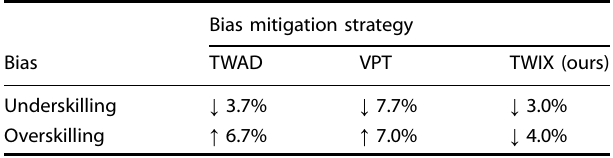
Fig. 4 TWIX can improve AI system performance while mitigating bias across hospitals. The performance (AUC) of SAIS before and after having adopted TWIX when assessing the skill-level of a needle handling and b needle driving. Note that SAIS is trained on data from USC and deployed on data from St. Antonius Hospital and Houston Methodist Hospital. The results are an average across ten Monte Carlo cross- validation folds and the shaded area represents one standard error. Table 1. Baseline strategies mitigate bias